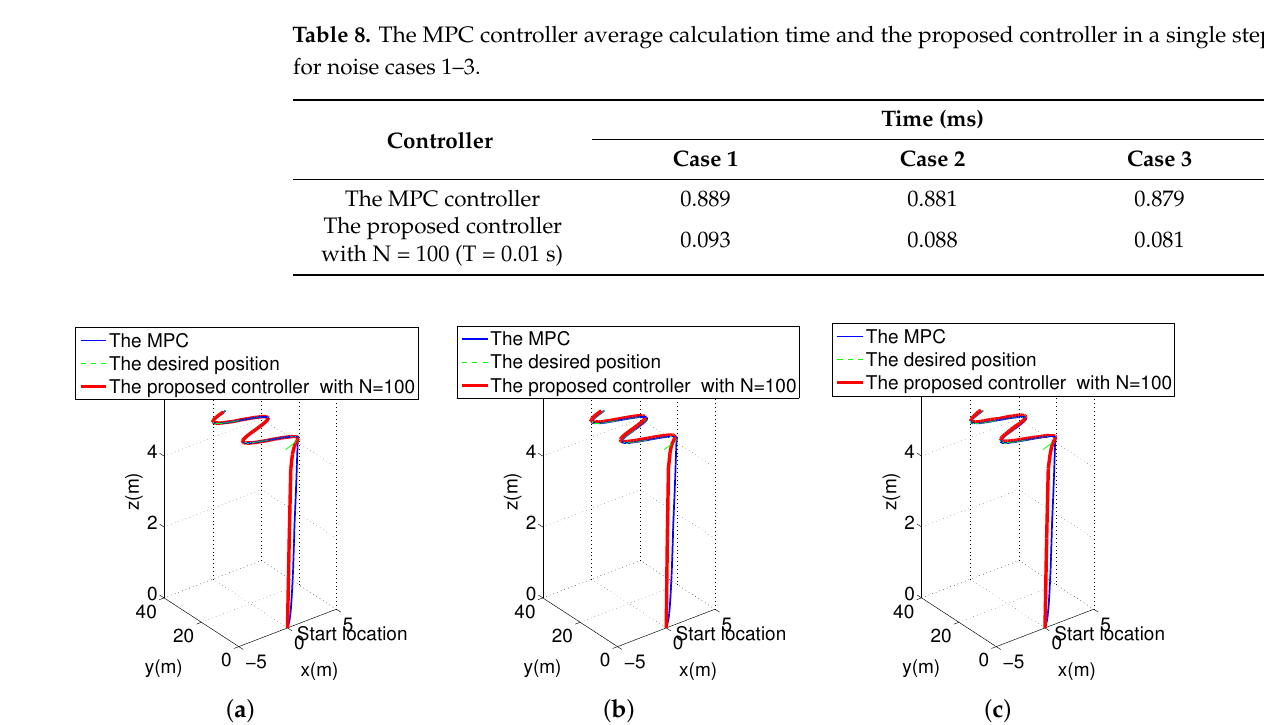
Figure 8. AUV 3D position tracking of the proposed controller ( T = 0.01s) and the MPC controller: ( a ) noise case 1, ( b ) noise case 2, and ( c ) noise case